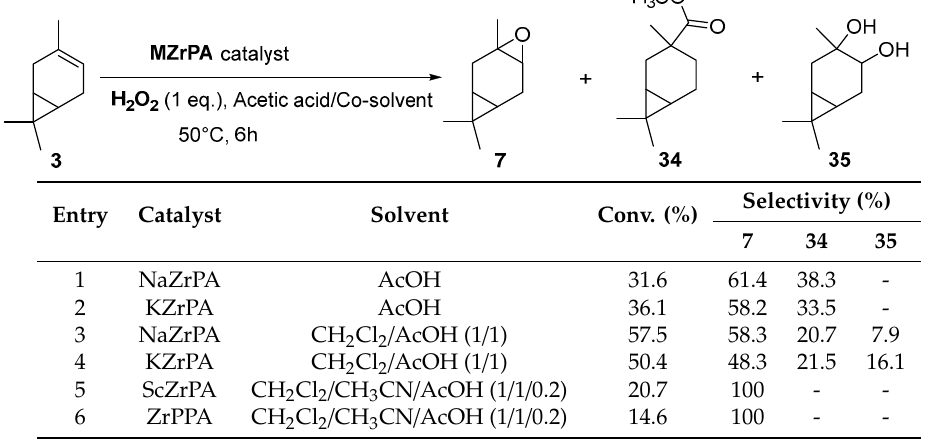
Table 10. Metal phosphates or phosphonates-catalyzed oxidation of 3-carane a (adapted from reference [43]).